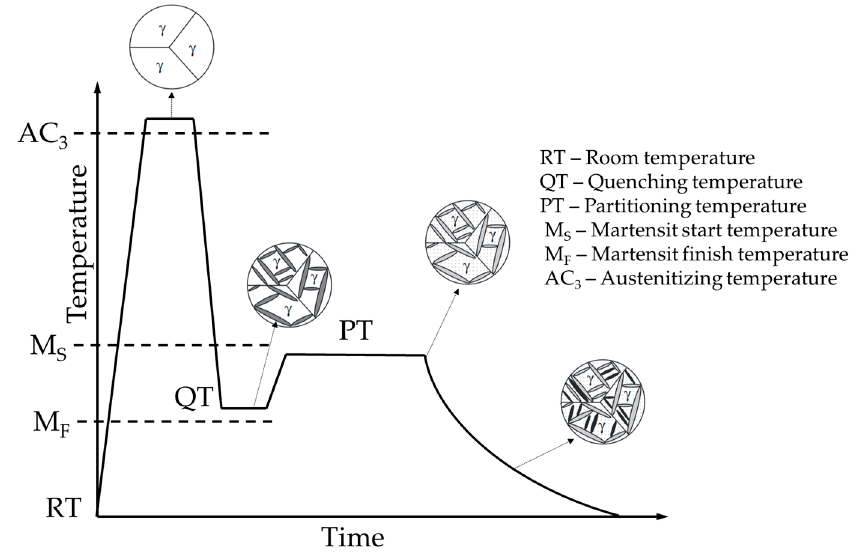
Figure 1. Schematic representation of the Q-P process as a two-step process, after [2]. During the partitioning step, carbon-enrichment in austenite leads to its (partial) stabilization. While during subsequent cooling, some fresh martensite is formed, a volume fraction of about 10% of retained austenite remains.